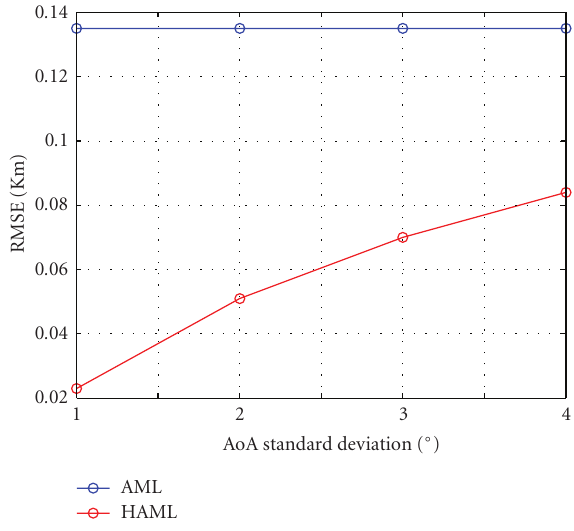
Figure 3: Influence of the AOA variances on the position accuracy with 2-BS HAML and 3-BS AML